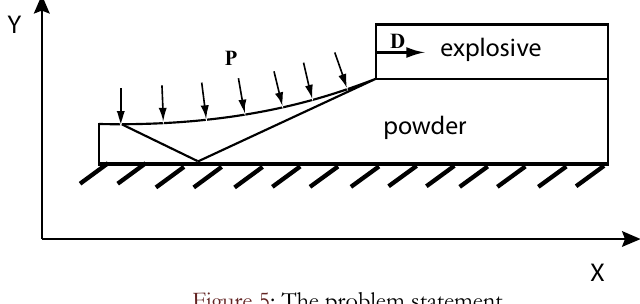
Figure 5: The problem